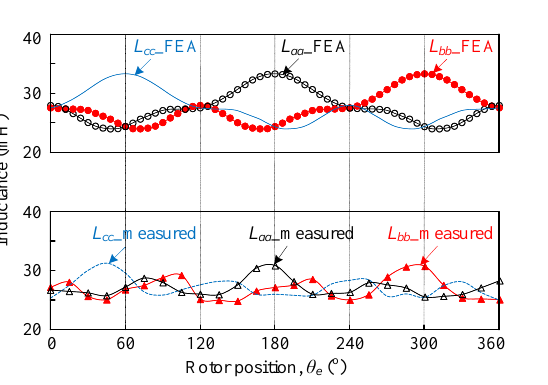
Figure 11. Comparison of measured and simulated self-inductances.